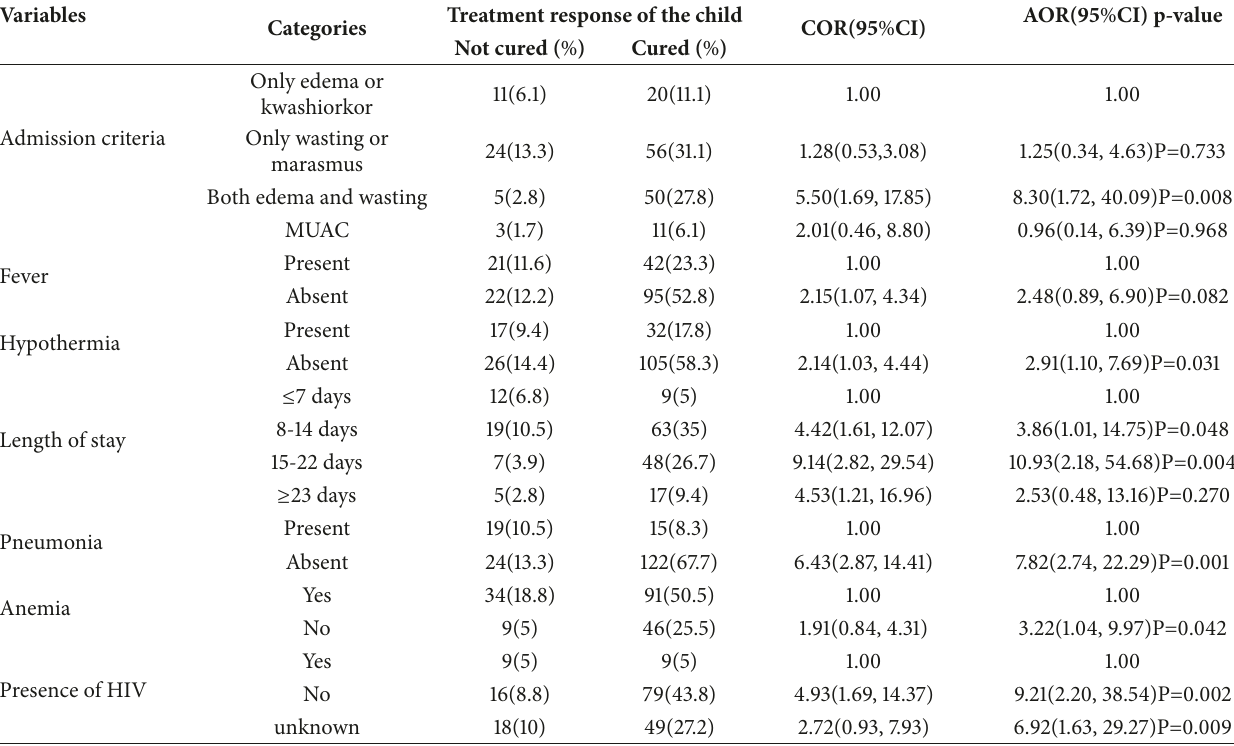
Table 5: Results of binary and multivariable logistic regression analysis indicating determinants of treatment outcome of children admitted to pediatric ward of NRH by SAM from November 2015 to April 2017